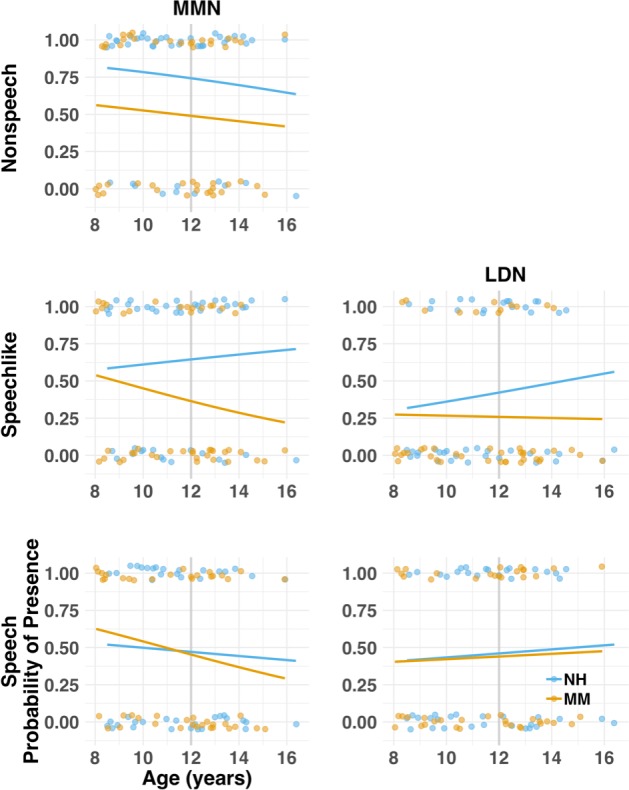
Probability of presence of the MMN and LDN for each group (MM vs. NH) as a function of age (cross-sectional study).Individual (circles) and group (lines) data are shown for each condition where a significant MMN/LDN was found at the group level (ie, there was no significant LDN in the nonspeech condition, see text). At the individual level, components were either present (probability = 1) or absent (probability = 0). Solid lines result from a logistic regression fitting a general linear model with age as a predictor and presence/absence of the component as the outcome variable. For illustrative purposes, age is represented a continuous variable, but was treated as a categorical variable (Y vs. O) in the analyses (see main text). The grey vertical lines on each subplot represent the median age split into the Y (left of the line) and O (right of the line) age bands. Across ages and conditions, children with MMHL were less likely to show present MMNs but not LDNs than their NH peers.